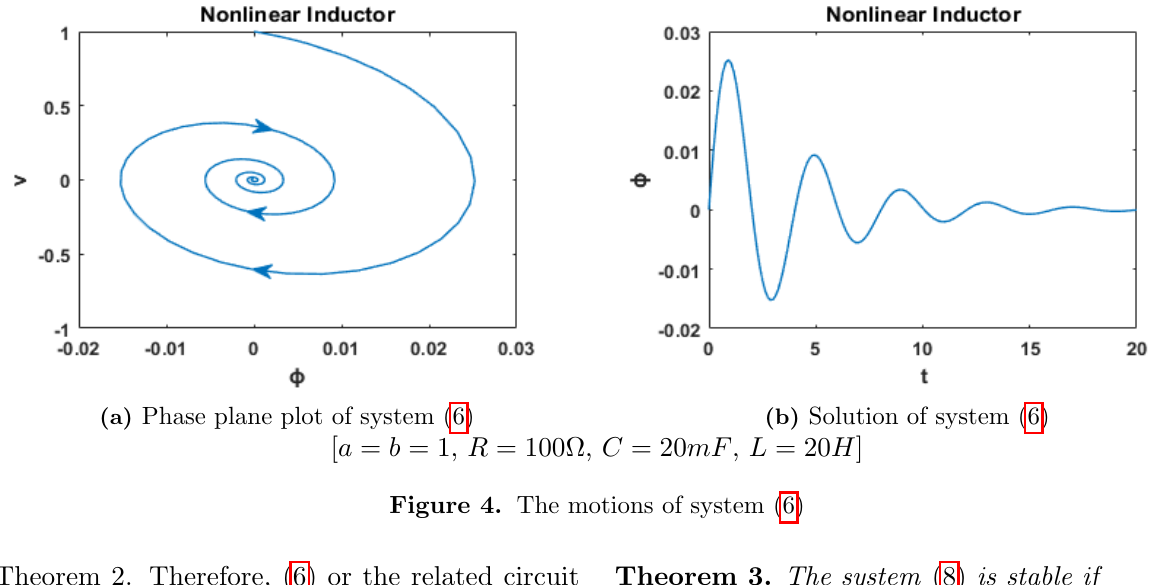
Figure 4. The motions of system (6)